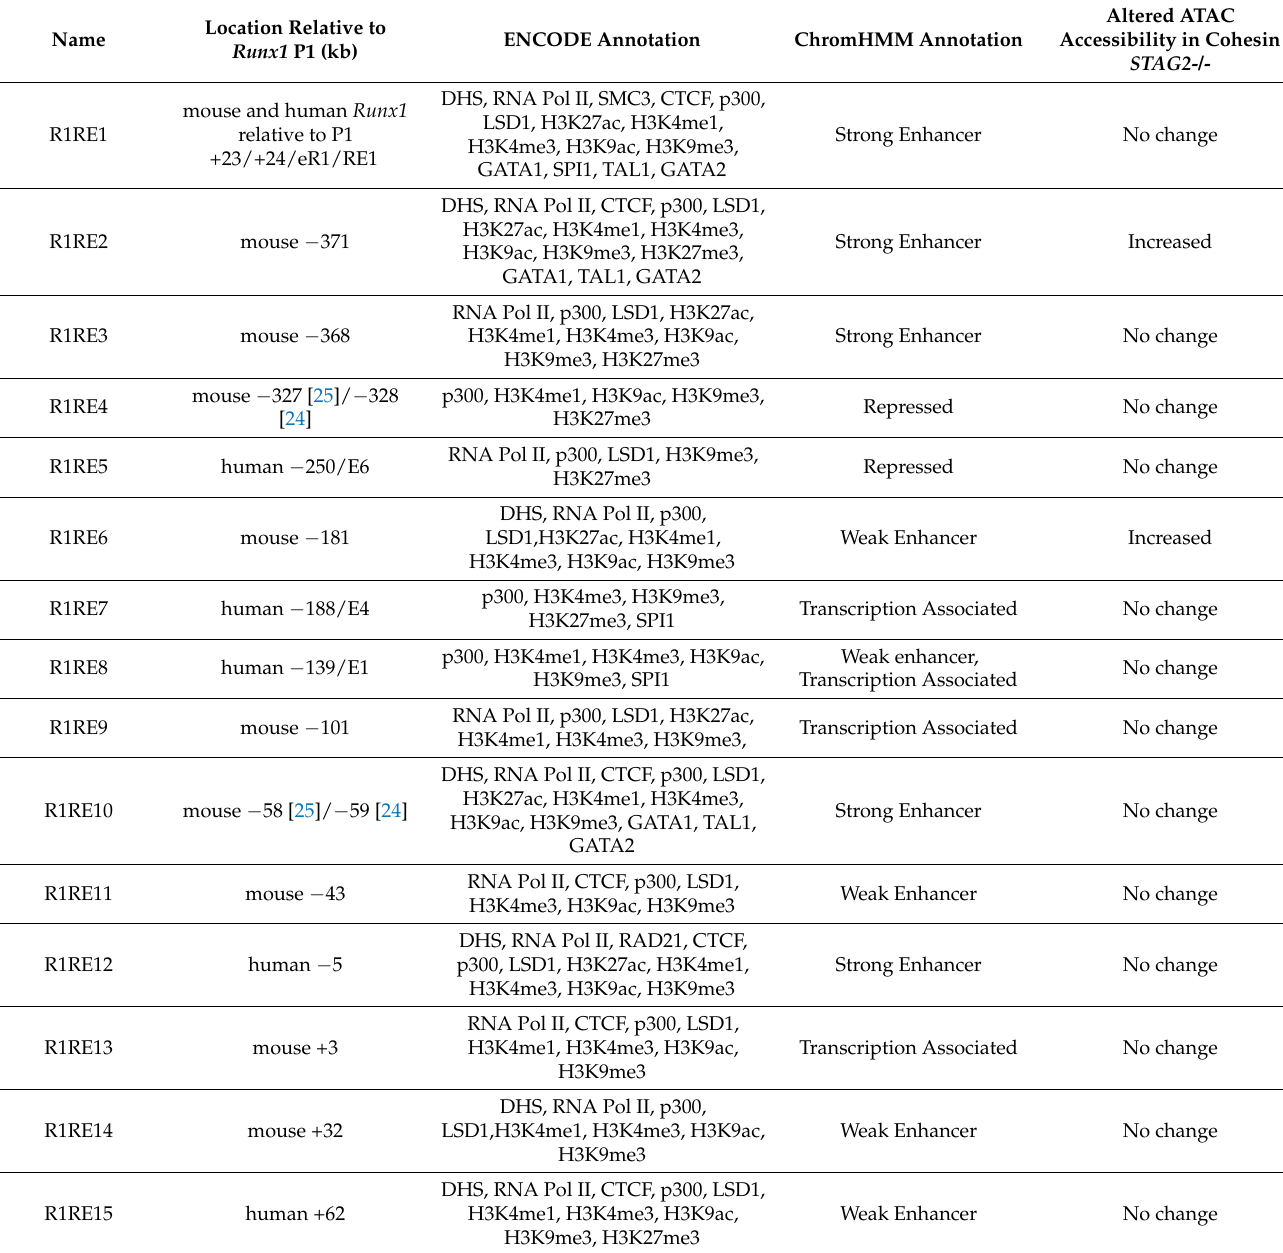
Table 2. Annotations of identified R1REs in K562